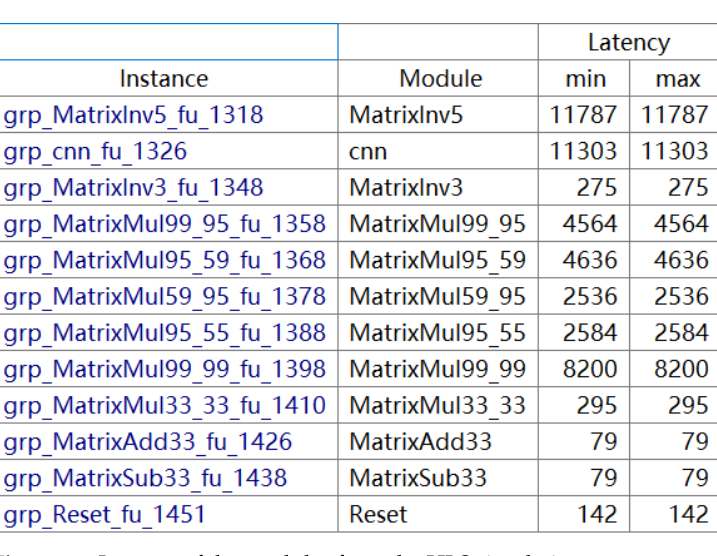
Figure 14. Power analysis from the implemented system.